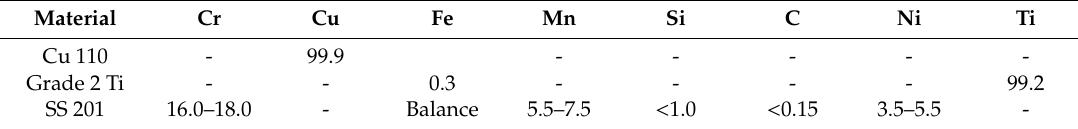
Table 2. The nominal composition (wt %) of the materials used in this